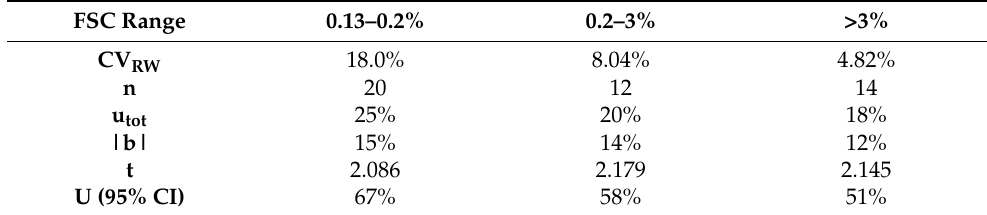
Table 1. Intra-assay coefficients of variability, freedom of degrees, total uncertainty, bias and used t-values for the new FSC